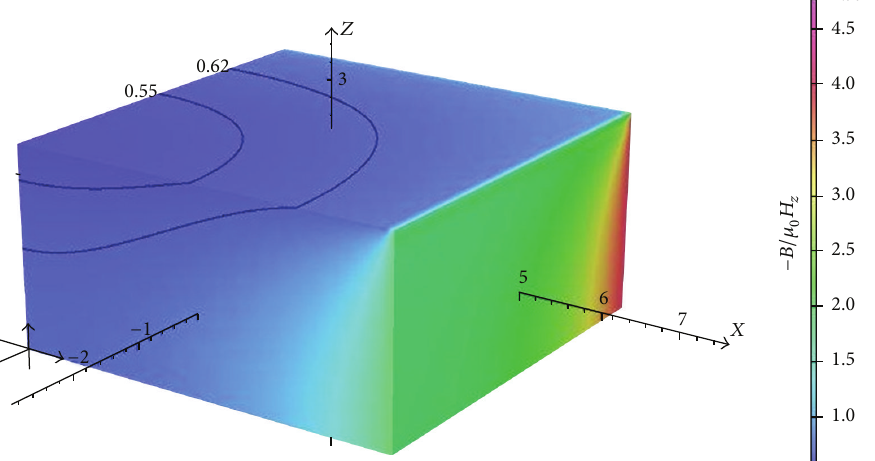
Figure 8: Variation of −𝐵 𝑧 /𝜇 0 𝐻 𝑧 inside the sample with dimensions 10 × 10 × 4.9 mm. The model includes one eighth of the sample. The upper right corner is the actual corner of the magnet and the lower left corner is the center of the magnet. The model depicts the sample produced from material 2 at 120 ∘ C.